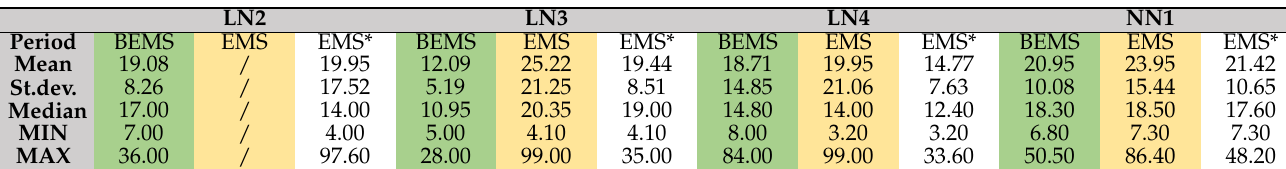
Table 2. Descriptive statistics for PM 2.5 [ µ g/m 3 ] data collected via the national and local network for air pollution monitoring in Novi Sad for the period of BEMS and EMS campaign in Novi Sad. EMS* denotes EMS data with Aralkum Desert episode excluded from